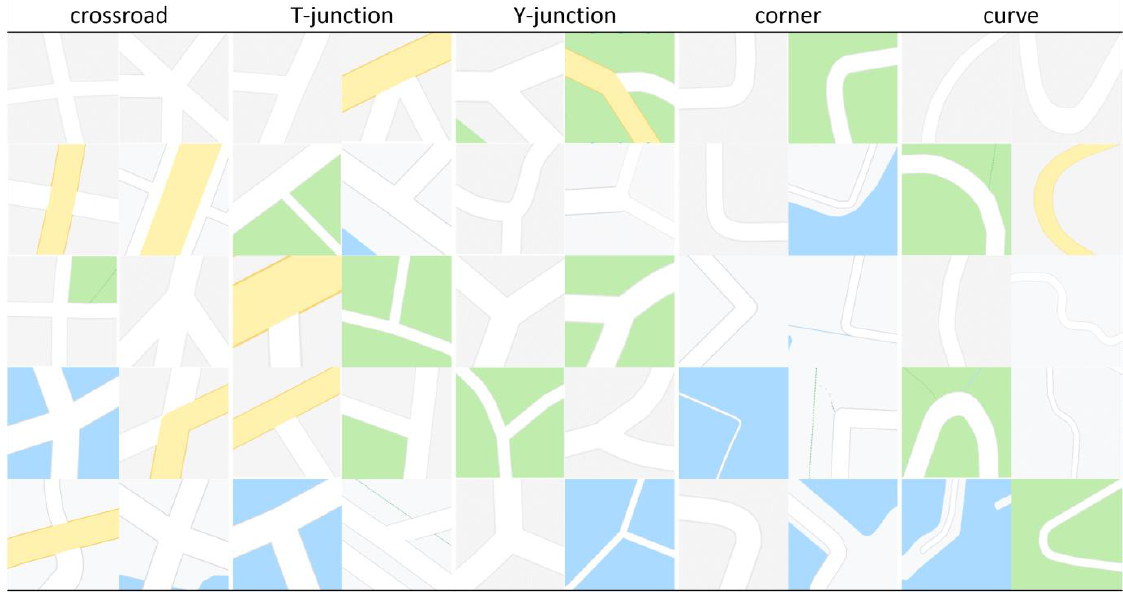
Figure 3. Architecture of road FG and BG image classification model and road characteristics classification model.